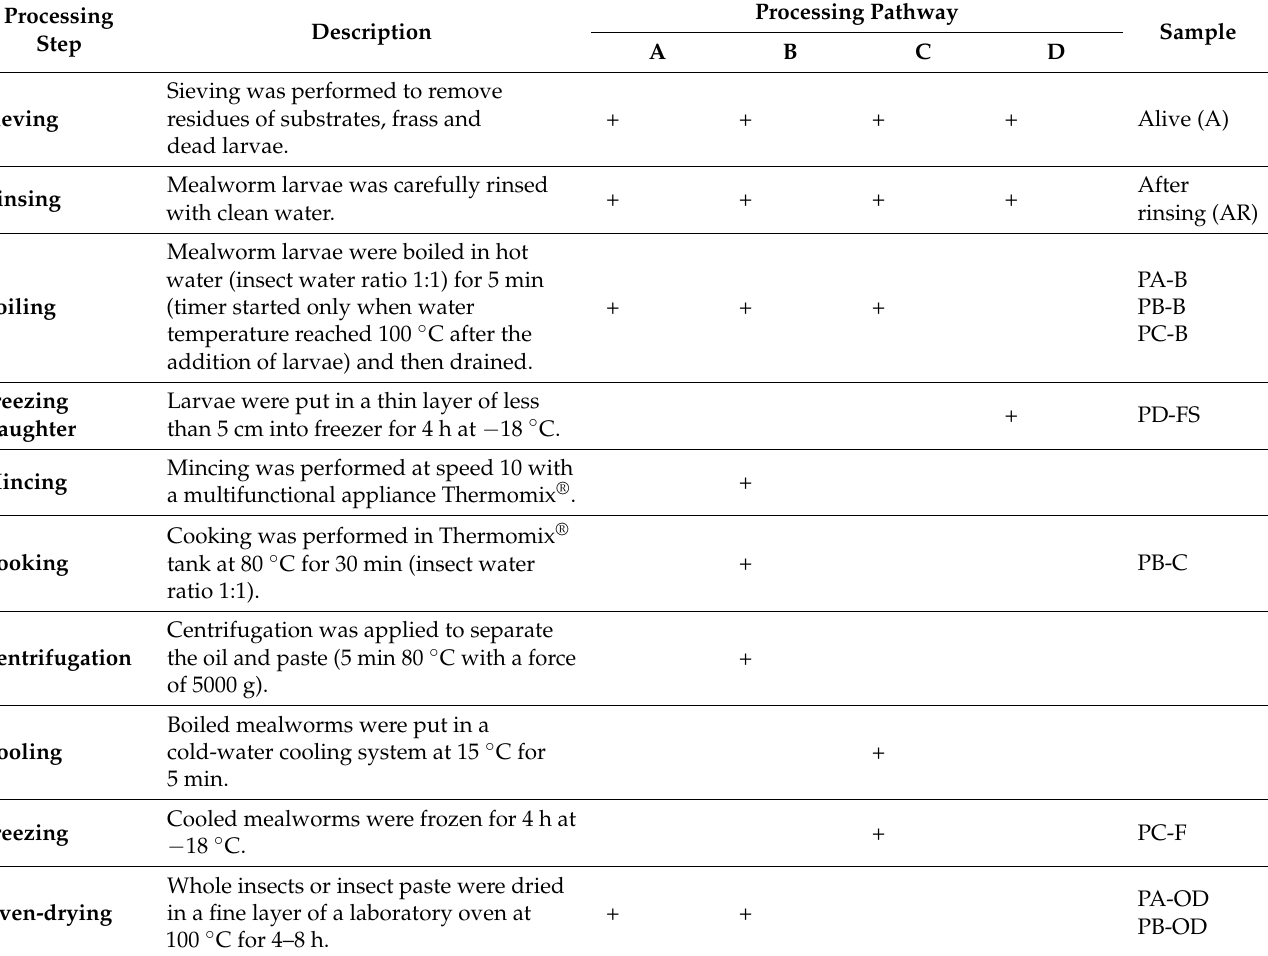
Table 1. Description of four processing pathways and samples collected (adapted from